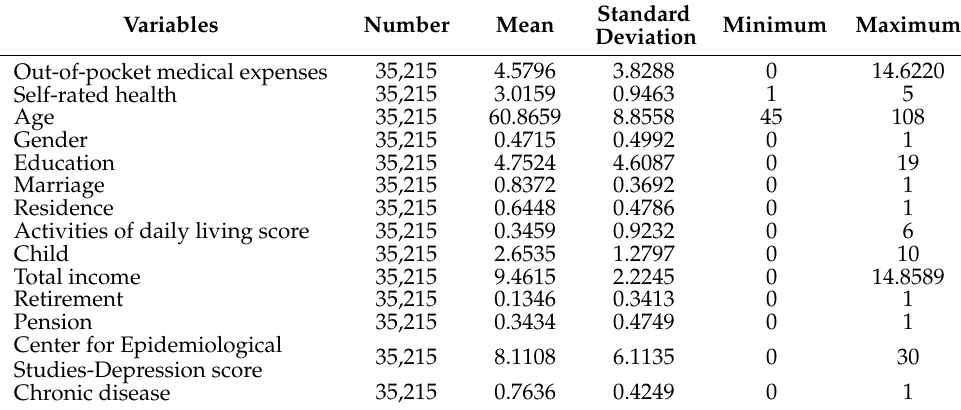
Table 3. Descriptive statistics for the main study